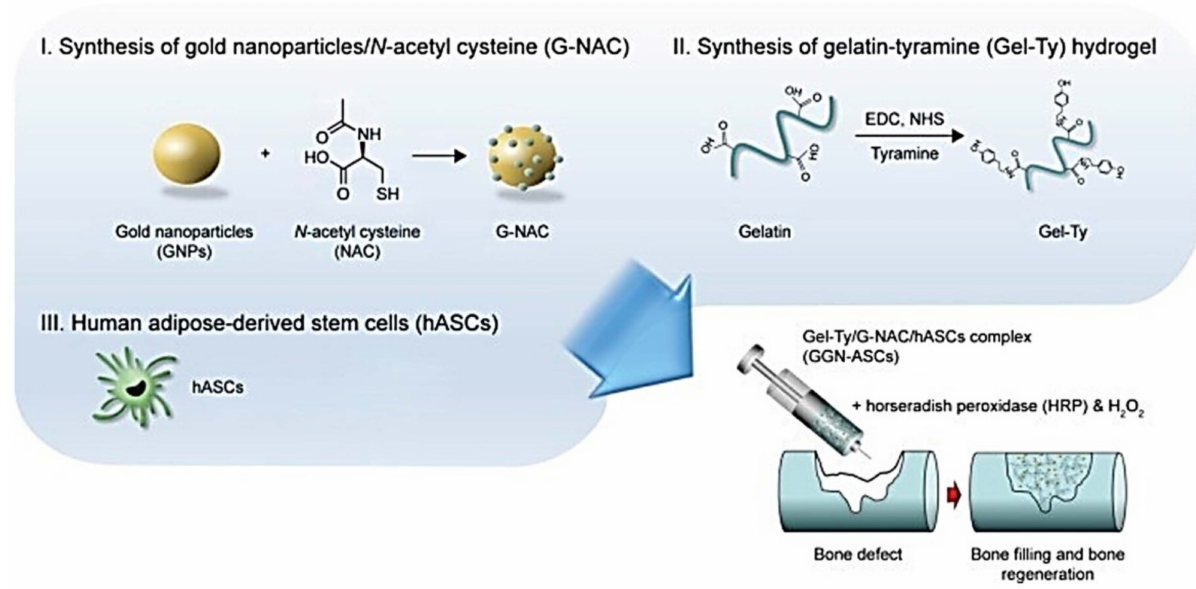
Figure 11. Schematic diagram shows the preparation enzyme cross-linked gelatin hydrogel for the bone regeneration applications. (Reproduced with permission from [82] under common creative CC-BY license,